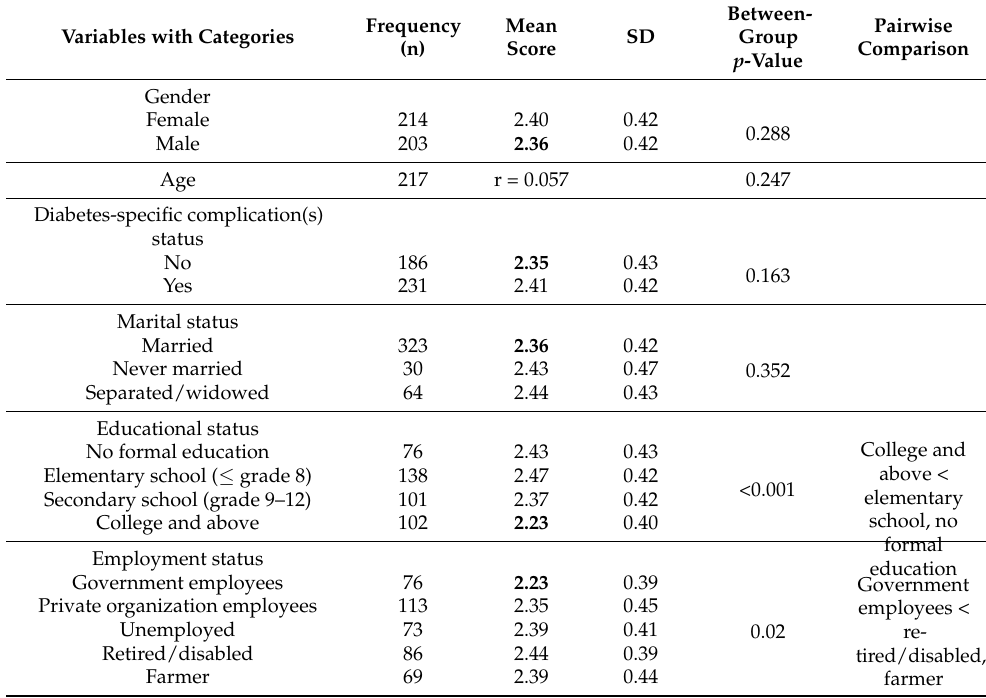
Table 6. Relationships between DQOL-AO scores and demographic variables and pairwise comparison among people living with type 2 diabetes attending Nekemte Specialized Hospital, 2020 ( n =